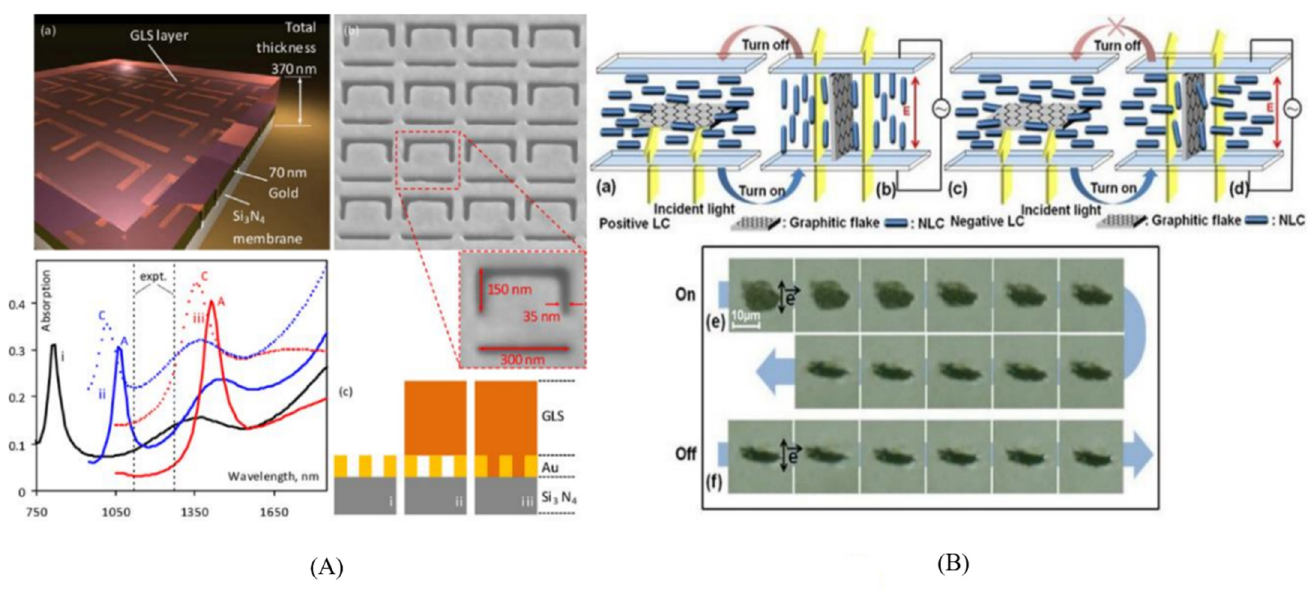
Figure 10. ( A ). Metamaterial electro-optic switch: ( a ) A hybrid device with planar plasmonics Au metamaterial coated with GLS chalcogenide glass on a SiN membrane. ( b ) Before GLS deposition, SEM of the asymmetric split-ring ASR slit array. ( c ) ASR structure computed optical absorption spectra without GLS film. Inside the figure (c), the black plot labeled i: with GLS flat film, the blue plot labeled ii: when the GLS also fills the slits in the gold; the red plot labeled iii: solid and dashed lines refer to the GLS phases of amorphous A and crystalline C, respectively. (Reprinted with permission with Rights managed by AIP Publishing) ( B ). Electro-optic behavior of the graphic flake display: in positive NLC ( a , b ) and ( c , d ) in negative NLC, before and after applying an electric field. ( e , f ) Showing the reorientation of a graphitic flake in the negative dielectric anisotropy LC as a result of the applied electric field (Reprinted with permission from OSA Publishing).